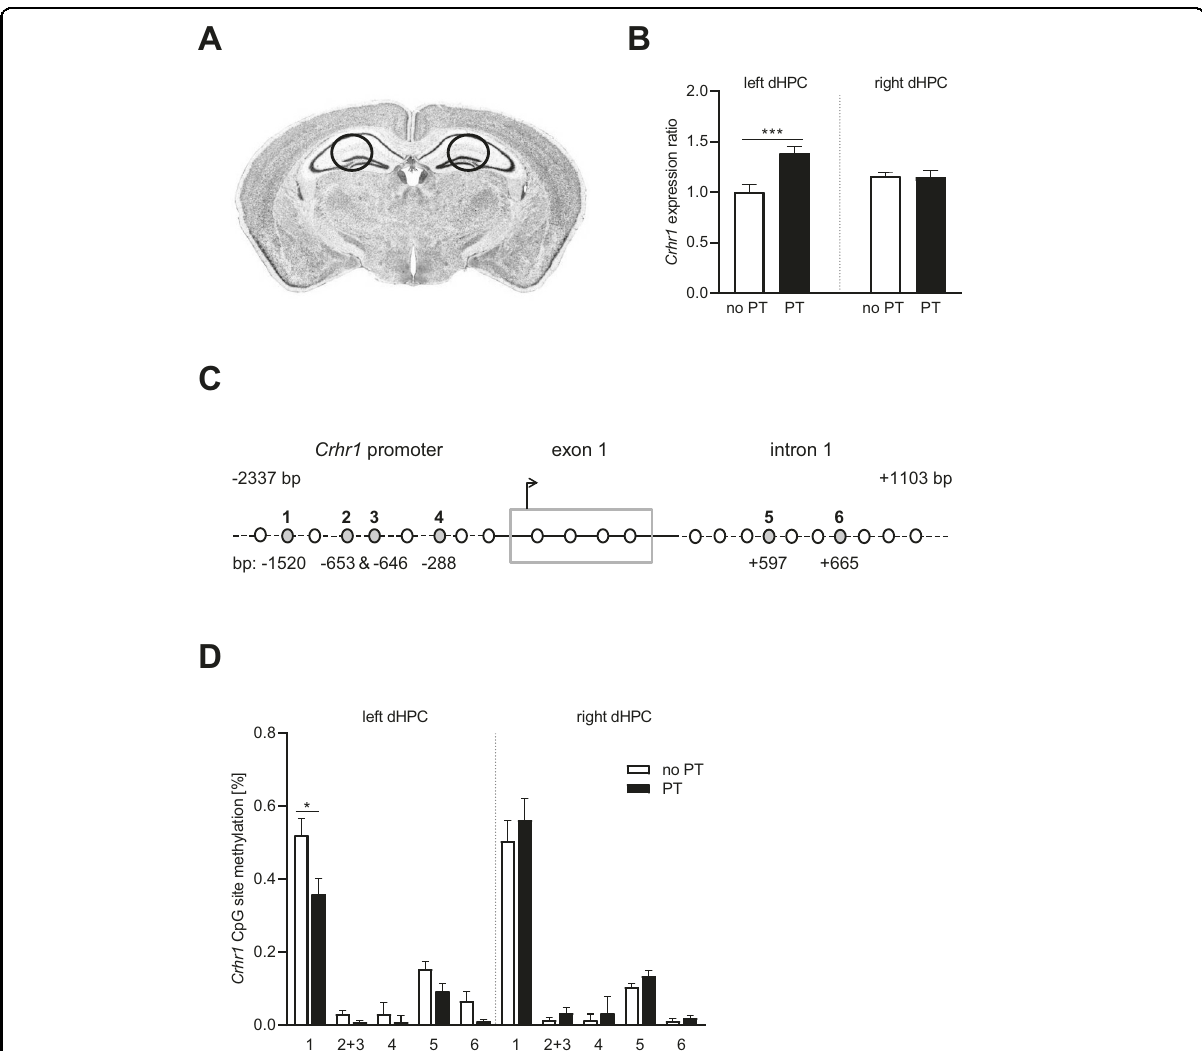
Fig. 3 Expression and methylation analysis of Crhr1 in the dHPC of PT adult male mice compared to a no PT control group. A Representative microphotograph with labels of the dissected dHPC region. B Results of the expression analysis of Crhr1 in the left and right dHPC of PT adult male mice compared to a control group. The dotted gray line separates the results from left and right dHPC. Crhr1 expression was signi fi cantly increased in the left dHPC of PT offspring (*** p < 0.001, post hoc Fisher ’ s LSD test), but not changed in the right dHPC as compared to no PT mice. C Schematic representation of the Crhr1 region of interest and localization of CpG sites (white and gray circles) investigated by methylation analysis. The promoter, the fi rst exon and intron of Crhr1 were analyzed for methylation changes. The gray circles indicate the position of differentially methylated CpG sites as identi fi ed by bisul fi te conversion and mass spectroscopy. The shown positions of the respective CpG sites are based on NC_000077.6 ( Mus musculus strain C57BL/6J chromosome 11, GRCm38.p2). D Differentially methylated Crhr1 CpG sites in the left and right dHPC of PT and no PT mice. The dotted gray line separates the results from left and right dHPC. CpG site 2 + 3 are in juxtaposition to each other and thus have been analyzed together due to technical limitations. *p < 0.05, independent samples t / u -test. See “ Results ” for detailed statistical